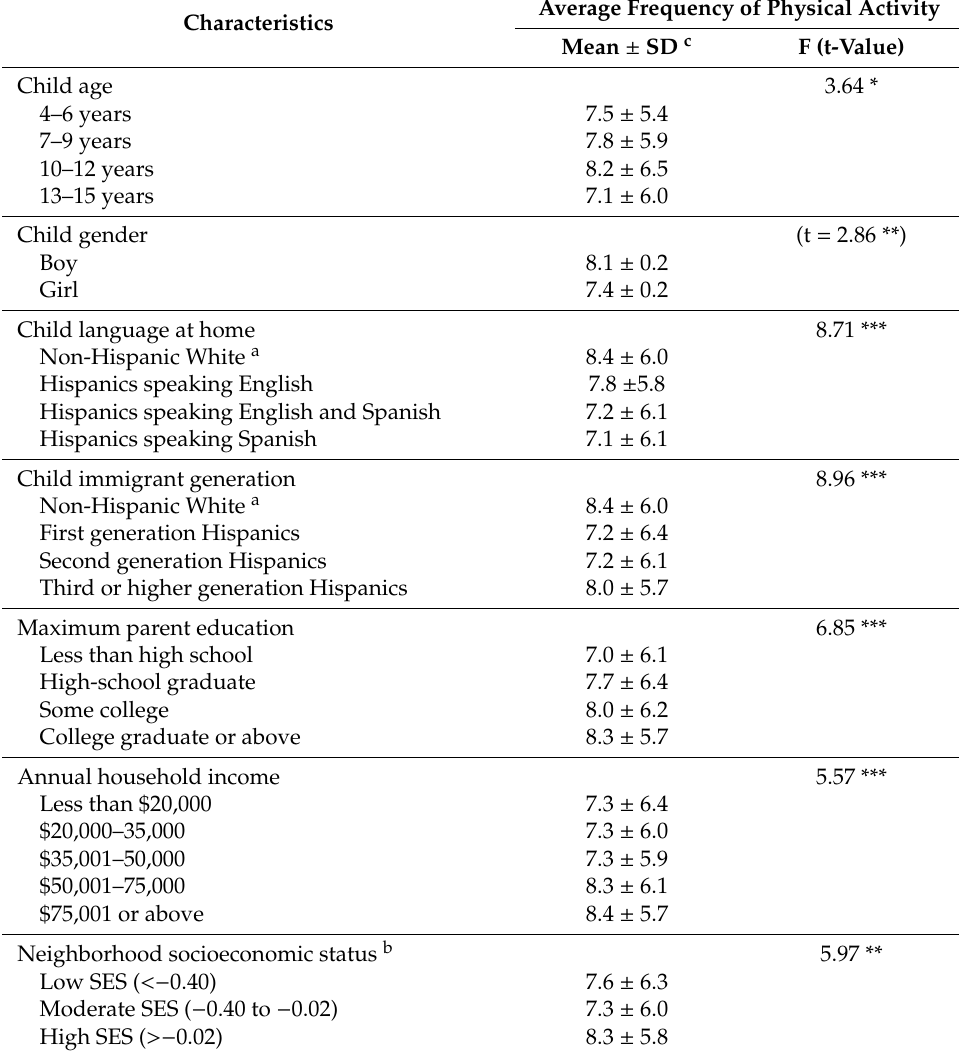
Table 2. Bivariate statistics, n =